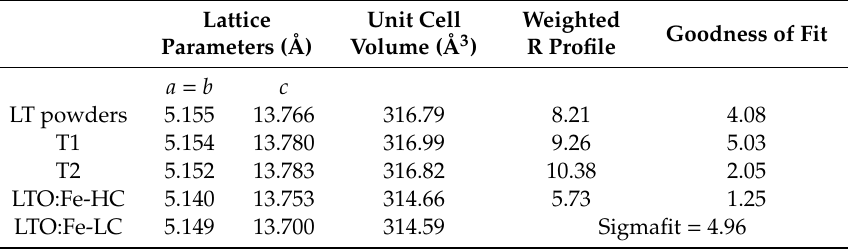
Table 2. Crystal lattice parameters and unit cell